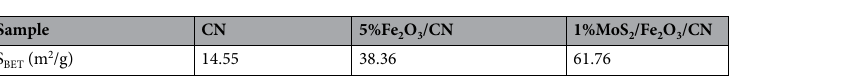
Table 1. The specific surface areas of CN, 5%Fe 2 O 3 /CN and 1%MoS 2 /Fe 2 O 3 /CN.